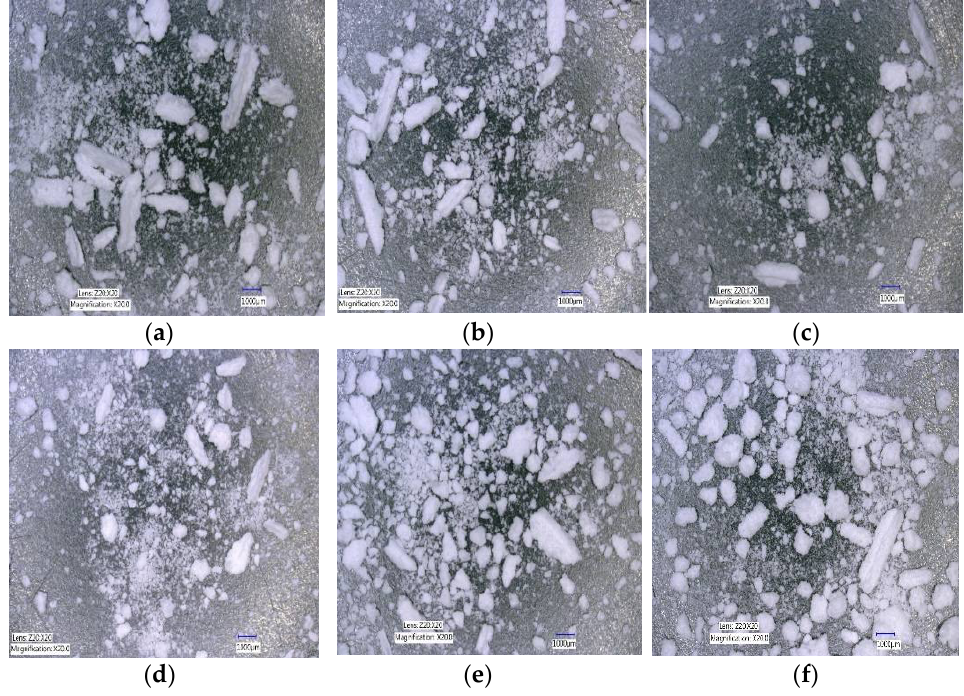
Figure 8. Microscopic images of lactose granules produced at varying screw speed at SFL—0.041 and PFN—1.71403 × 10 −5 (L/S 0.048). ( a ) 150 rpm; ( b ) 250 rpm; ( c ) 400 rpm; ( d ) 500 rpm; ( e ) 750 rpm; and ( f ) 1000 rpm.